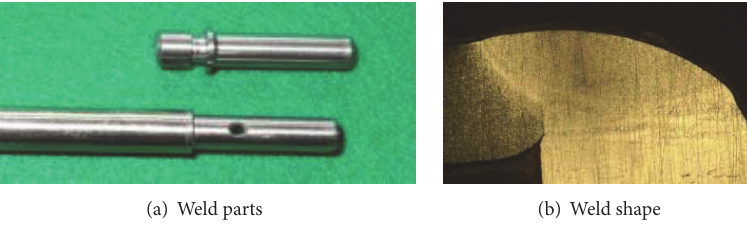
Figure 9: Joint parts before welding and weld shape after welding.